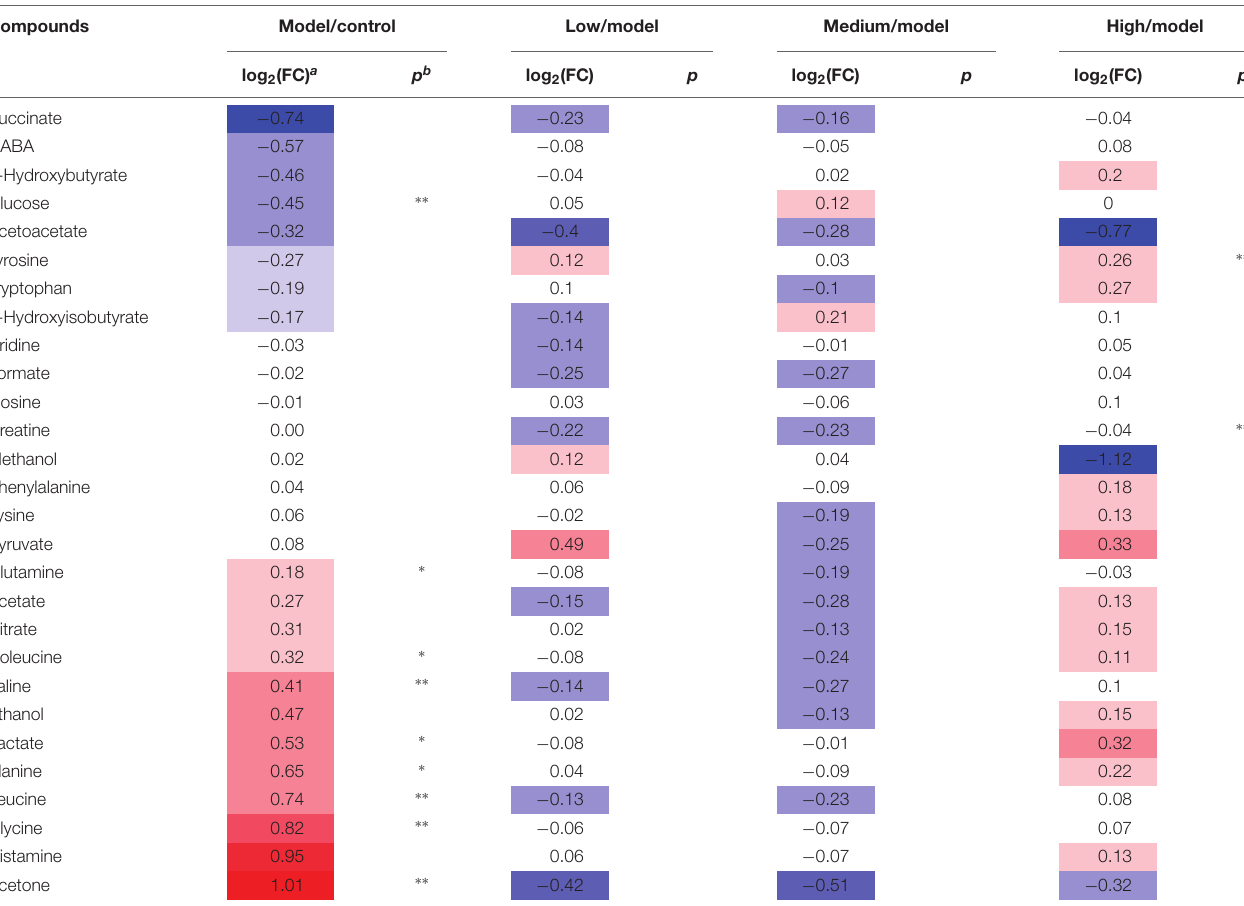
TABLE 2 | Potential marker metabolites in rat serum identified by 1 H-NMR and their variations among groups and the associated p values. Compounds Model/control Low/model Medium/model